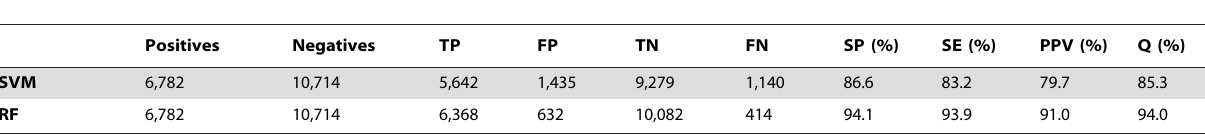
Table 1. The performances of SVM model and RF model in classification of